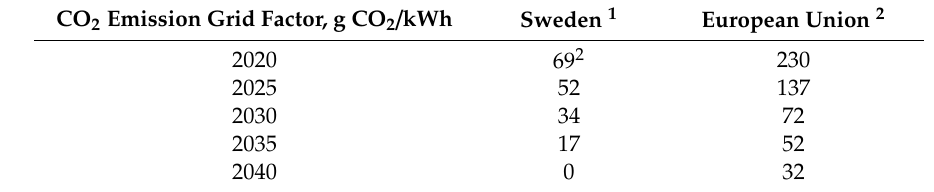
Table A2. CO 2 emission grid factor of Sweden and Europe for the years